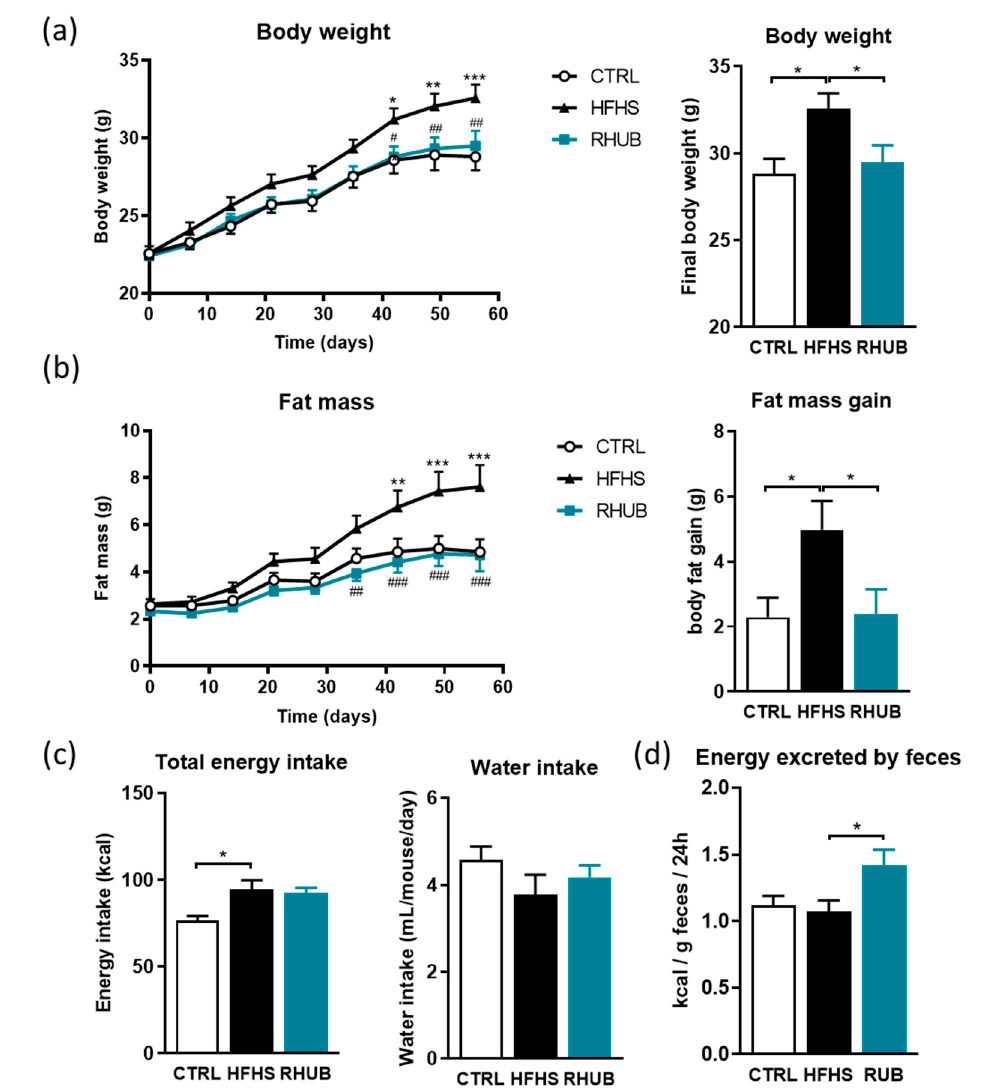
Figure 1. Rhubarb root extract prevents obesity and fat mass accumulation in diet-induced obese mice; ( a ) Body weight (g) over an 8 weeks period and final body weight; ( b ) Fat mass gain; (g) over an 8 weeks period and final fat mass gain; ( c ) Total energy intake (kcal) over the 8 weeks period and mean of the water intake (mL / mouse / day); ( d ) Energy measured in the feces at the end of the experiment (Kcal / g feces / 24 h). White, CTRL fed mice; Black, HFHS fed mice and Blue, HFHS fed mice supplemented with rhubarb. Data represent mean ± SEM. * p ≤ 0.05, ** p ≤ 0.01, *** p ≤ 0.005. # p ≤ 0.05, ## p ≤ 0.01, ### p ≤ 0.005. HFHS, High fat / high sucrose; RHUB, Rhubarb.